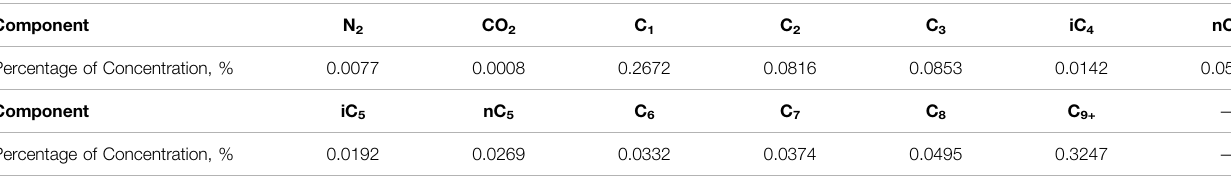
TABLE 1 | The oil component of H3 oil fi eld.